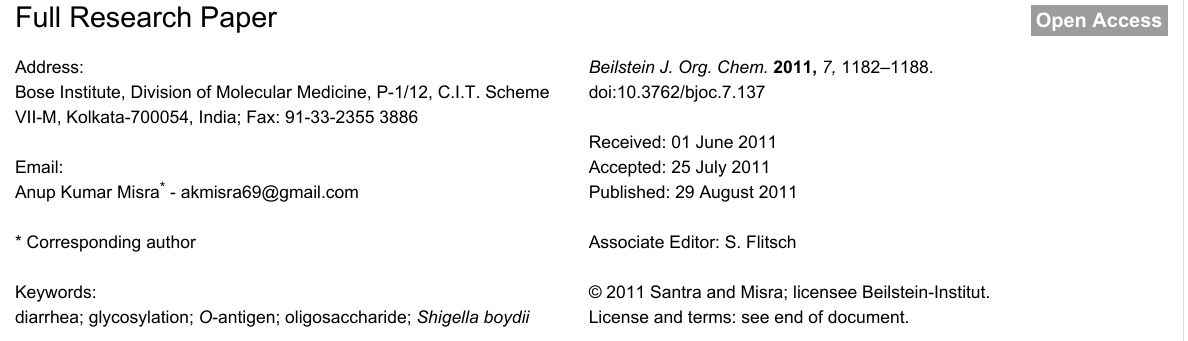
Figure 1: Structure of the tetrasaccharide repeating unit of the O -antigen of Shigella boydii type